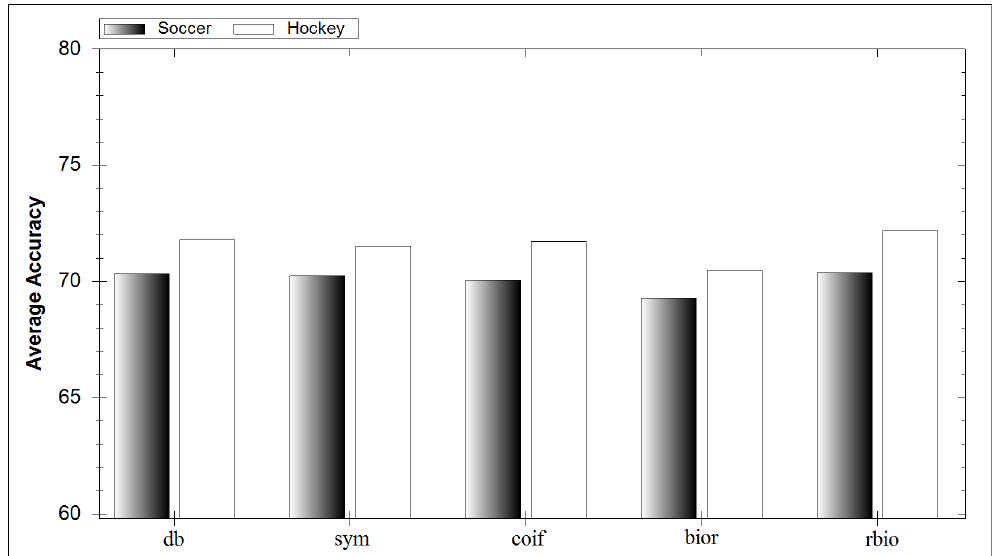
Figure 7. Effect of choice of wavelet.